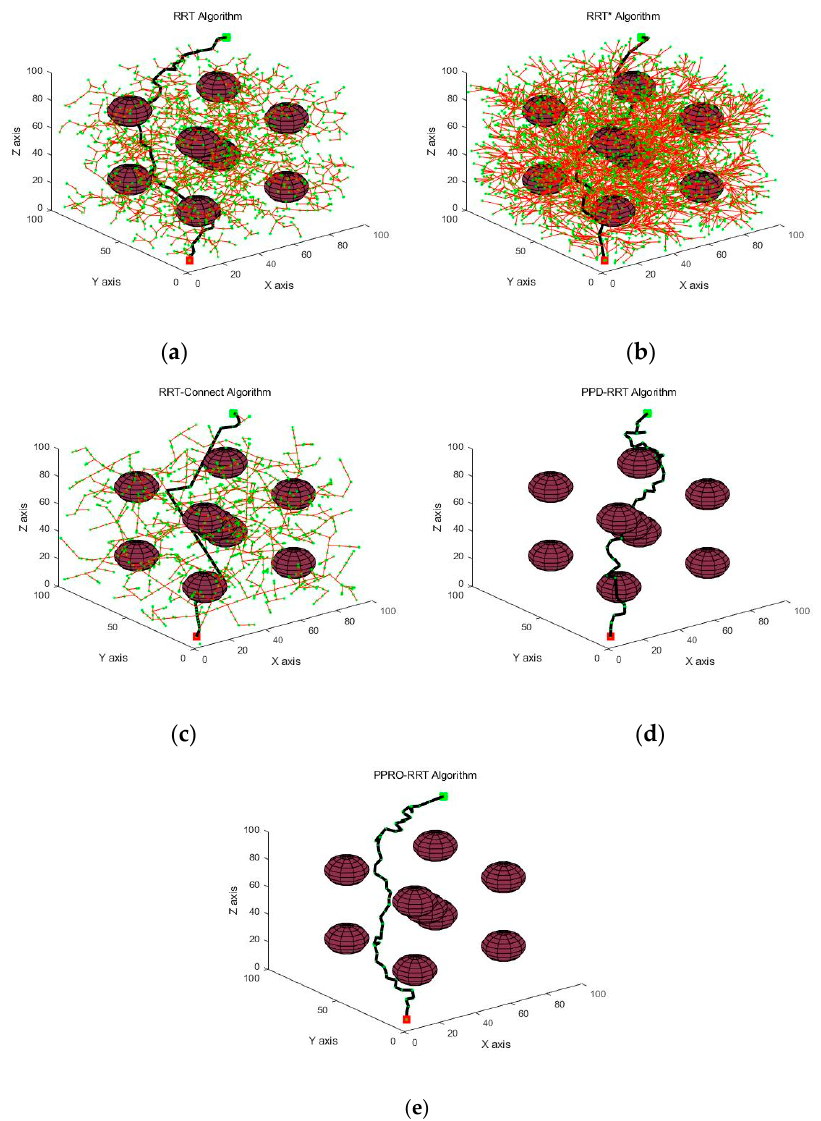
Figure 4. Paths planned by various algorithms in a simple environment. The red cube indicates the starting position and the green cube indicates the target position. The red sphere indicates the ob- stacles in the environment, the green dot indicates the points obtained by sampling during the path planning process, the red solid line indicates the branches of the random tree, and the black solid line indicates the feasible paths obtained. ( a ) RRT algorithm; ( b ) RRT* algorithm; ( c ) RRT-Connect algorithm; ( d ) PPD-RRT algorithm; ( e ) PPRO-RRT algorithm.